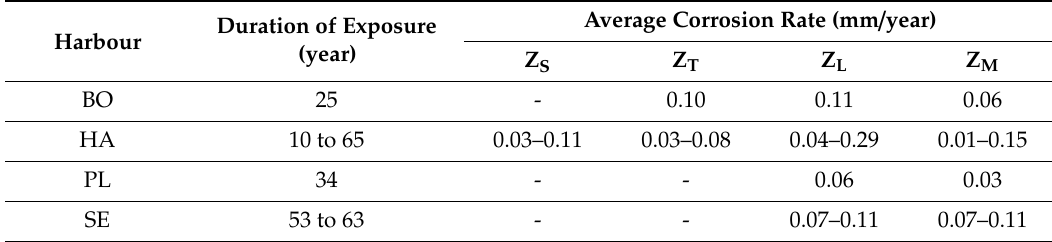
Table 2. Average corrosion rates at the four corrosion